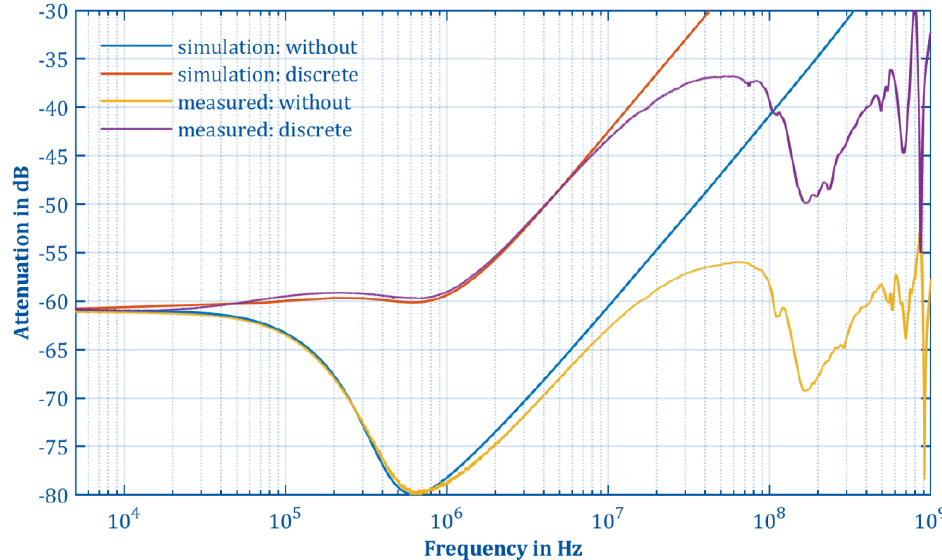
Figure A6. Comparison of the simulated and measured transmission responses. The transmission responses for the resistive voltage divider without a compensation electrode simulated (blue) and measured (yellow) and for the discrete shape compensation electrode simualted (red) and measured (purple) are shown.